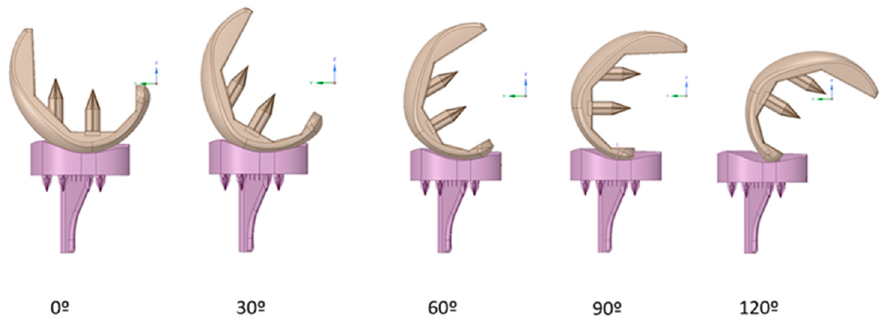
Figure 4. Bending angles considered in the Figure 4 . Bending angles considered in the analysis. Figure 4 . Bending angles considered in the analysis.